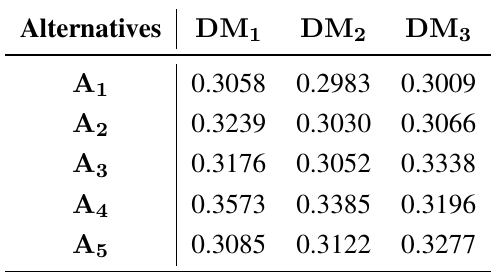
Table 5. Overall score matrix of